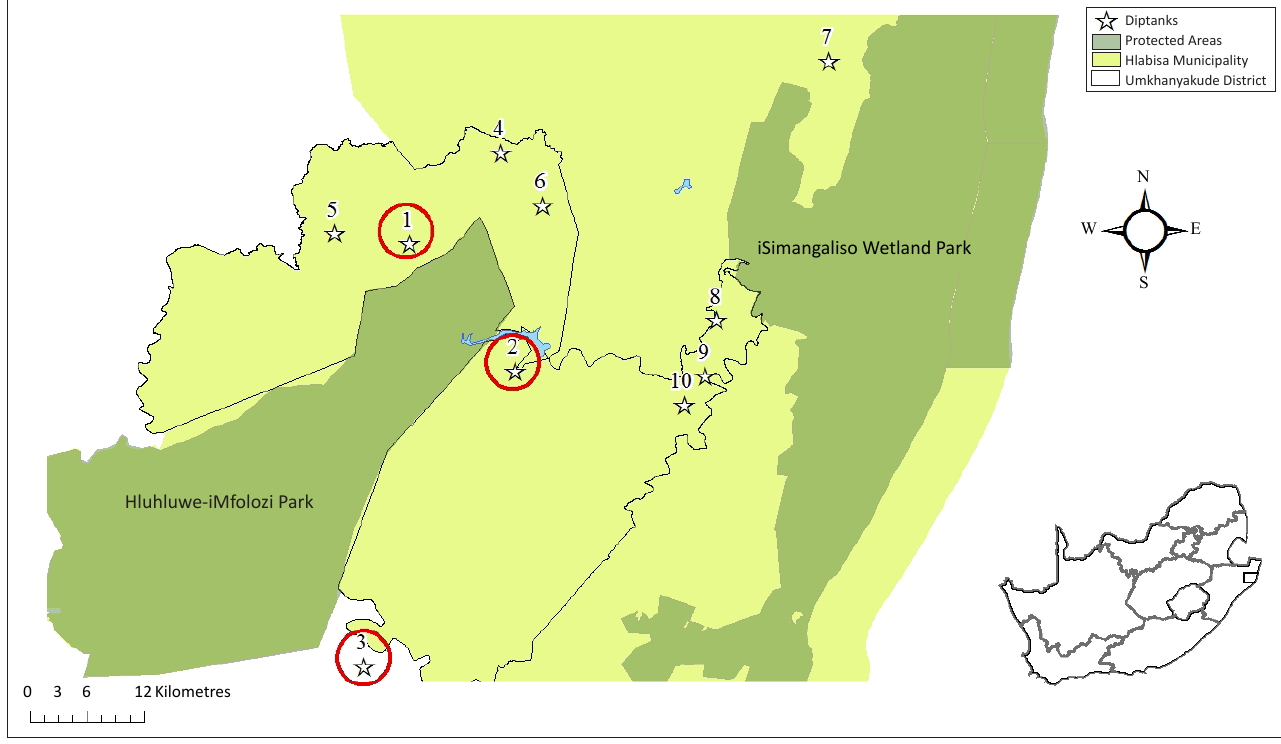
FIGURE 1: Study area in northern KwaZulu-Natal Province, South Africa with diptank locations, (1) Ekuphindisweni, (2) Mvutshini, (3) Ocilwane, (4) Bukhipha, (5) Nhlwathi, (6) Mzineni, (7) Nibela, (8) Gwenyambili, (9) Qakwini and (10) Mahlambanyathi. Circled diptanks indicate surveillance